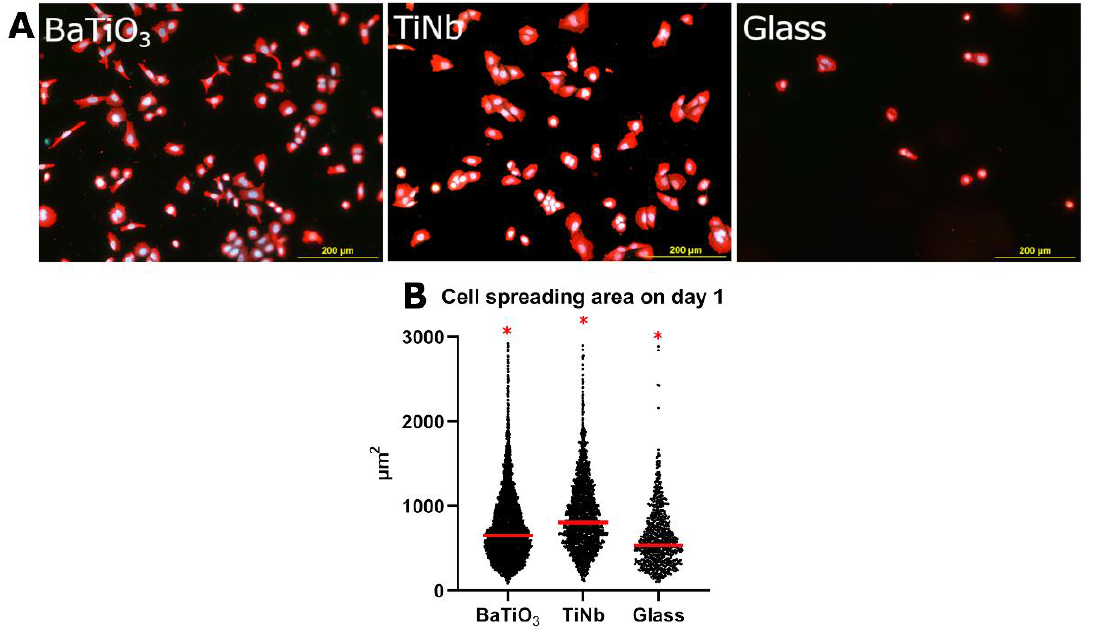
Figure 9. The morphology ( A ) and the violin plots showing the distributions of the cell spreading areas ( B ) of human osteoblast-like Saos-2 cells after 24 h in culture on Ti39Nb alloy coated with BaTiO 3 (BaTiO 3 ), on bare Ti39Nb alloy (TiNb), and on control microscopic glass coverslips (Glass). ( A ): The cells were fixed with the 70% frozen ethanol and stained with a combination of Hoechst #33258 (blue fluorescence) and Texas Red C 2 -maleimide (red fluorescence). Scale bar = 200 µm. ( B ): The violin plot from 708 to 2510 cells for each experimental group, obtained from two samples for each group. ANOVA, Kruskal-Wallis, and Dunn’s Methods. Red lines show median. Asterisks above the plots indicate experimental groups significantly differing from all other groups (* p ≤ 0.05) in the size of cell spreading